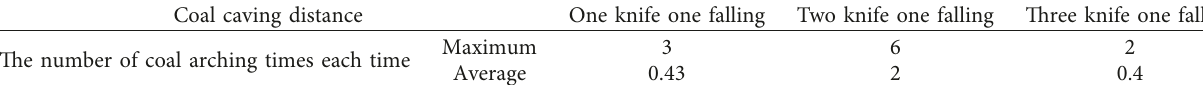
Table 8: Contrast ratio of arching at different coal caving distances.